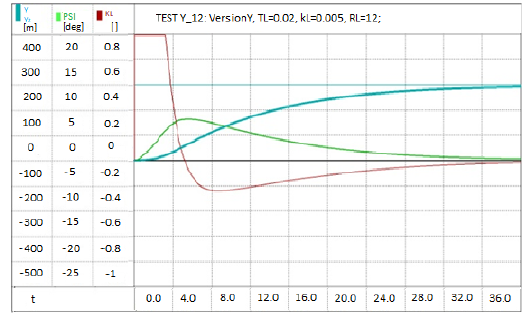
Figure 6. The transitional process of controlling flight Figure 9. The transitional process of controlling flight direction direction Y z , with preset step changes to the coordinate Y Y z , with preset step changes to the coordinate Y from 0 to from 0 to 300 metres. Testing the influence of the co-efficient 300 metres. Testing the influence of the derivative constant of reinforcement K L = 0.0025 with unchanged value of the RL with constant co-efficient of reinforcement K L = 0.005. derivative constant of R L = 6 Derivative constant of R L =